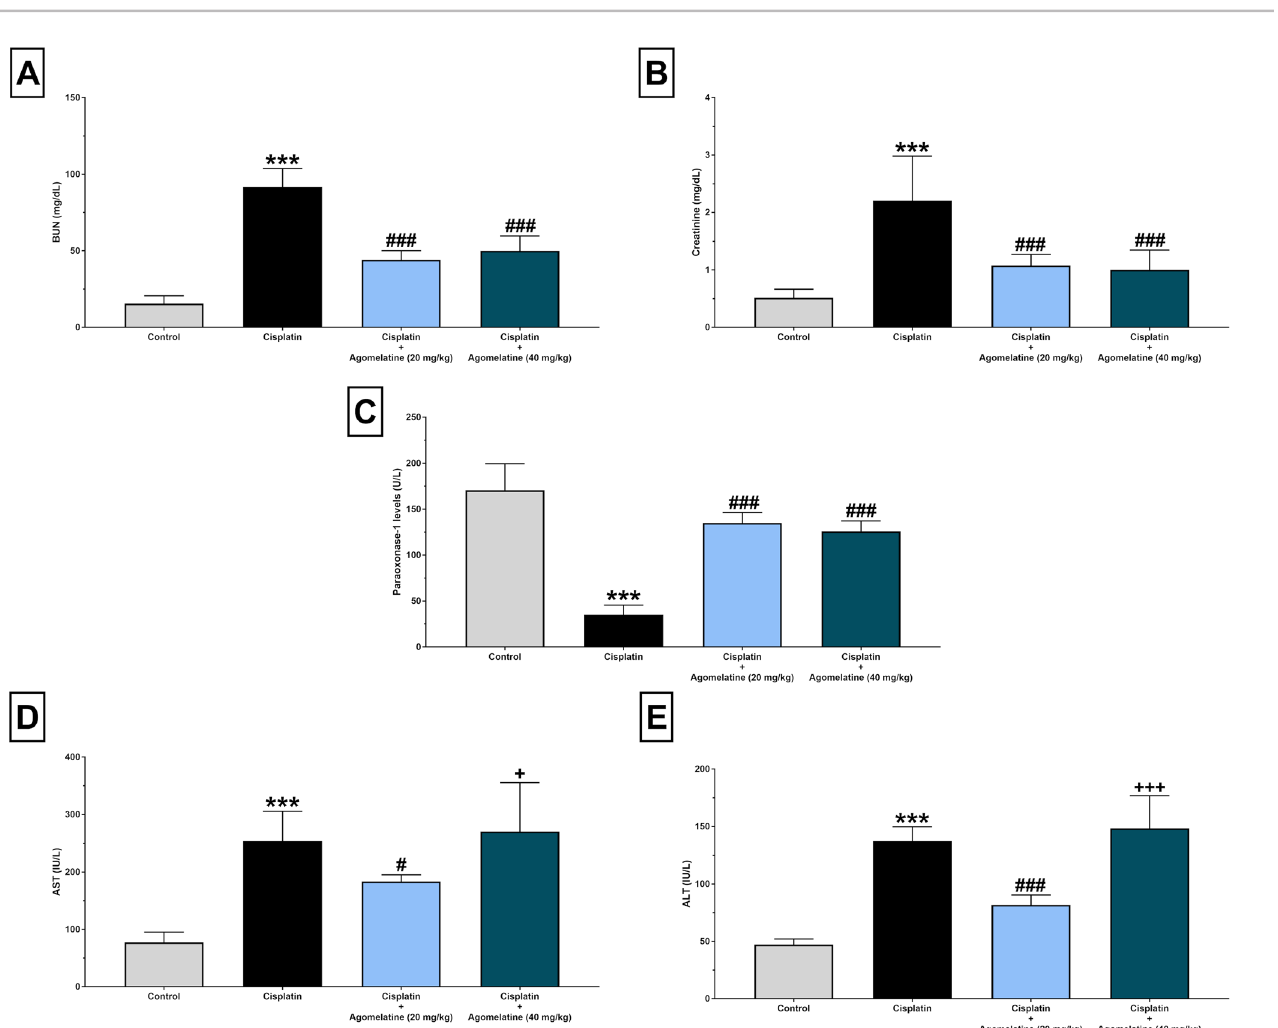
FIGURE 1 - Serum levels of selected markers. A: Blood urea nitrogen (BUN) B: Creatinine (Cr) C: Paraoxonase 1 (PON-1), D: Aspartate transaminase (AST), E: Alanine transferase (ALT). At the doses of 20 and 40 mg/kg, agomelatine prevented BUN and Cr increase and PON-1 decrease in serum levels. However, agomelatine (20 mg/kg) diminished cisplatin-induced AST and ALT increase, whereas agomelatine (40 mg/kg) failed to prevent the cisplatin-induced increase in AST and ALT levels. All data represented as mean±SD and stand for eight animals per group. *** p<0.001 versus control group and ### p<0.001, # p<0.05 versus cisplatin group and +++ p<0.001, + p<0.05 versus cisplatin+agomelatine (20 mg/kg) group. TABLE I - S erum levels of investigated parameters in all experimental groups Group BUN Creatine PON-1 AST ALT Control 15.6±5.08 0.518±0.148 171±28.8 77.3±18 47.3±4.82